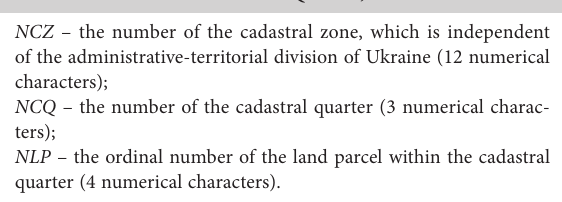
Figure 4. The structure of the “new” cadastral number of the land parcel (PKMU, 2012, art. 30 & 34)